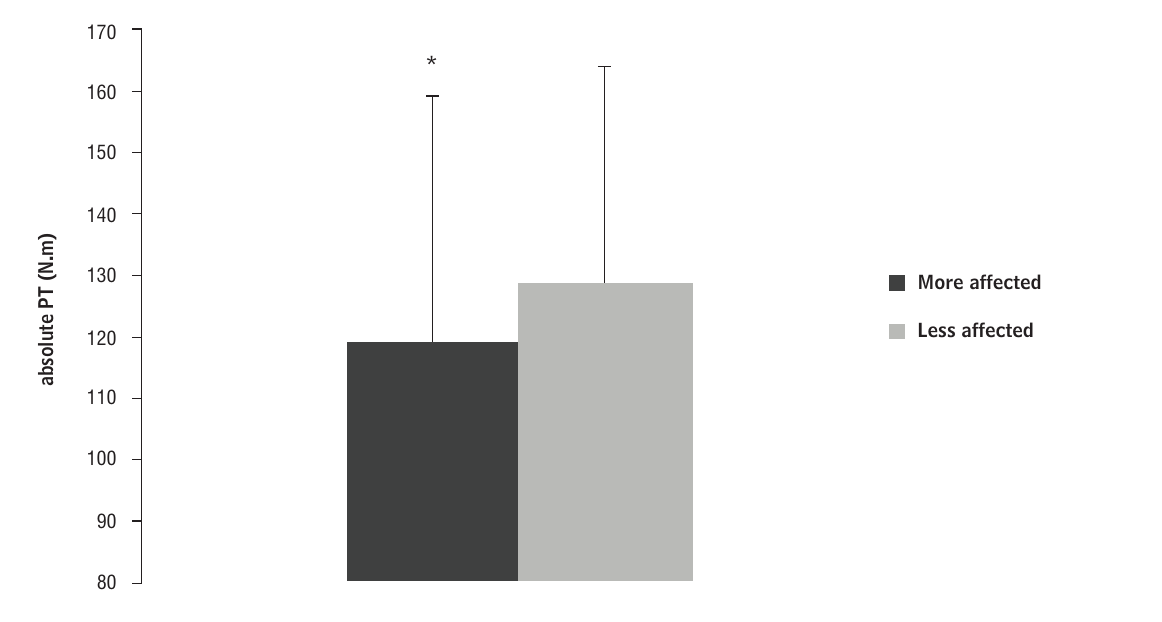
Graph 3 - Absolute peak torque (absolute PT) in the more affected and less affected limb in PG Legend: * = significantly different with regard to the less affected limb (p < 0.05). Source: Research data.